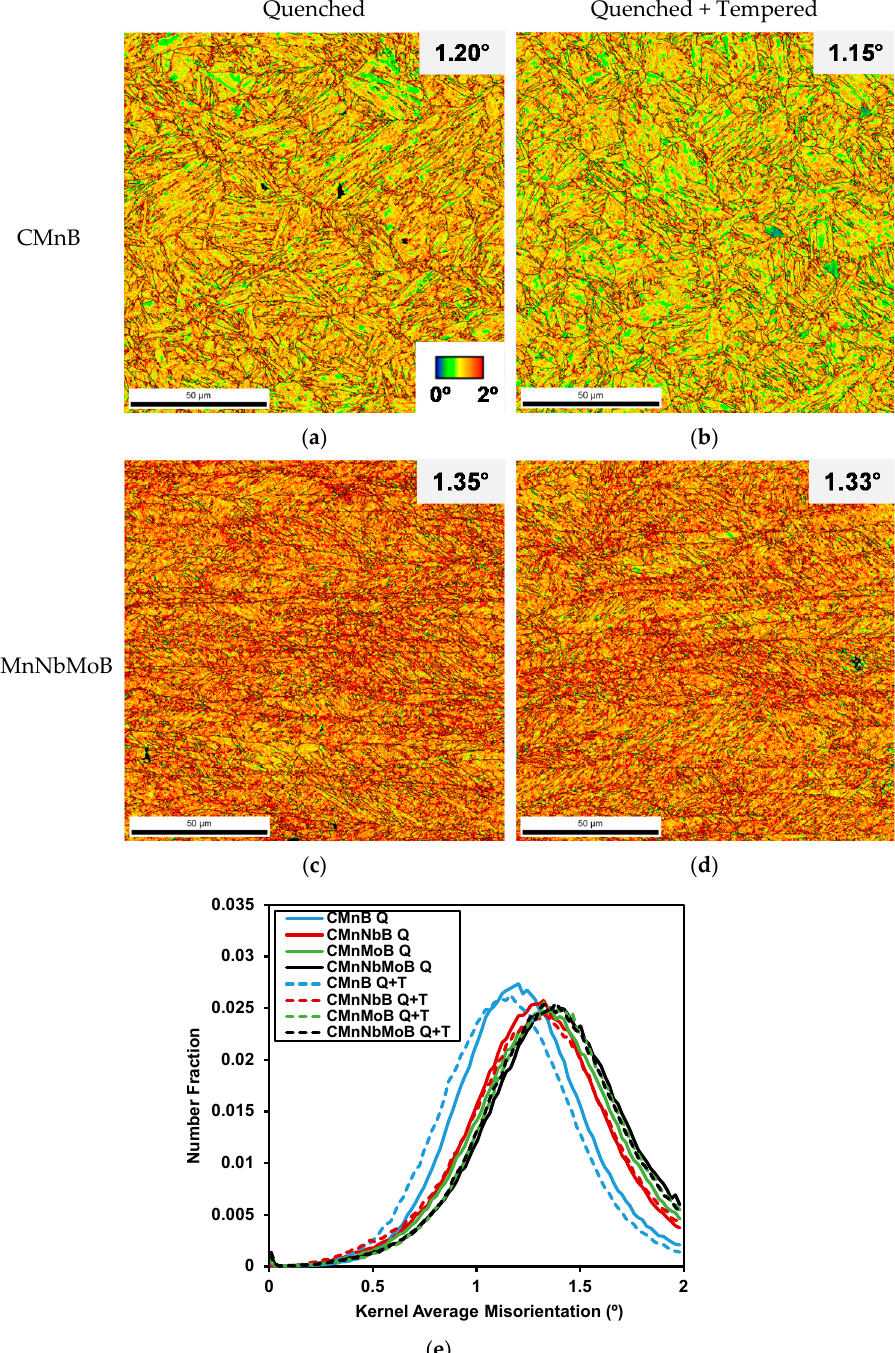
Figure 7. Kernel Average Misorientation maps corresponding to different steels (( a,b ) CMnB and ( c,d ) CMnNbMoB) and both conditions: ( a,c ) Q and ( b,d ) Q + T states. ( e ) KAM distributions corresponding to all the steel grades and both states.